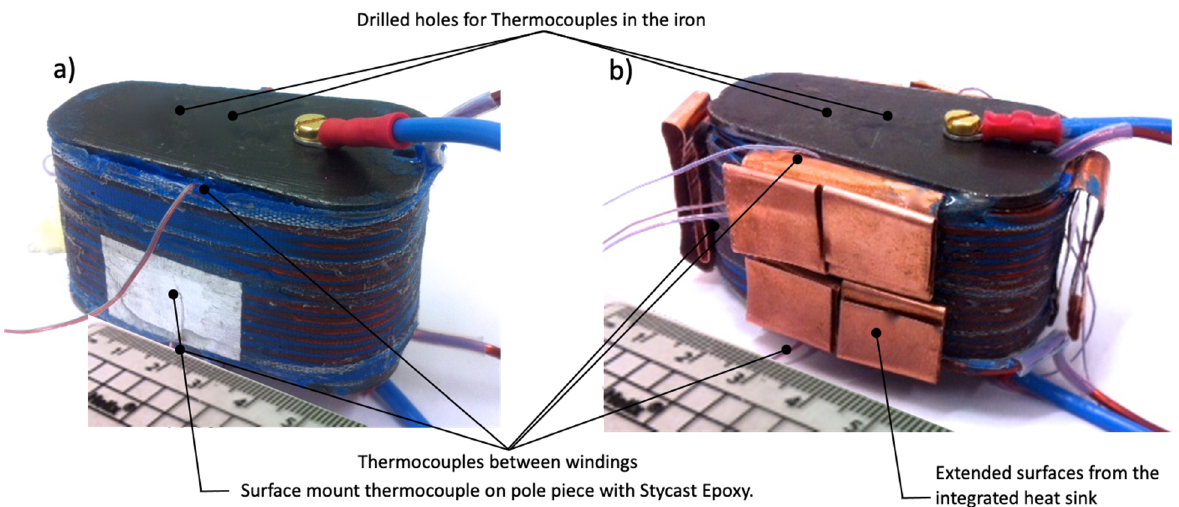
Figure 13. Prototypes of: ( a ) the traditional concentrated wound pole piece, and ( b ) the new construction.